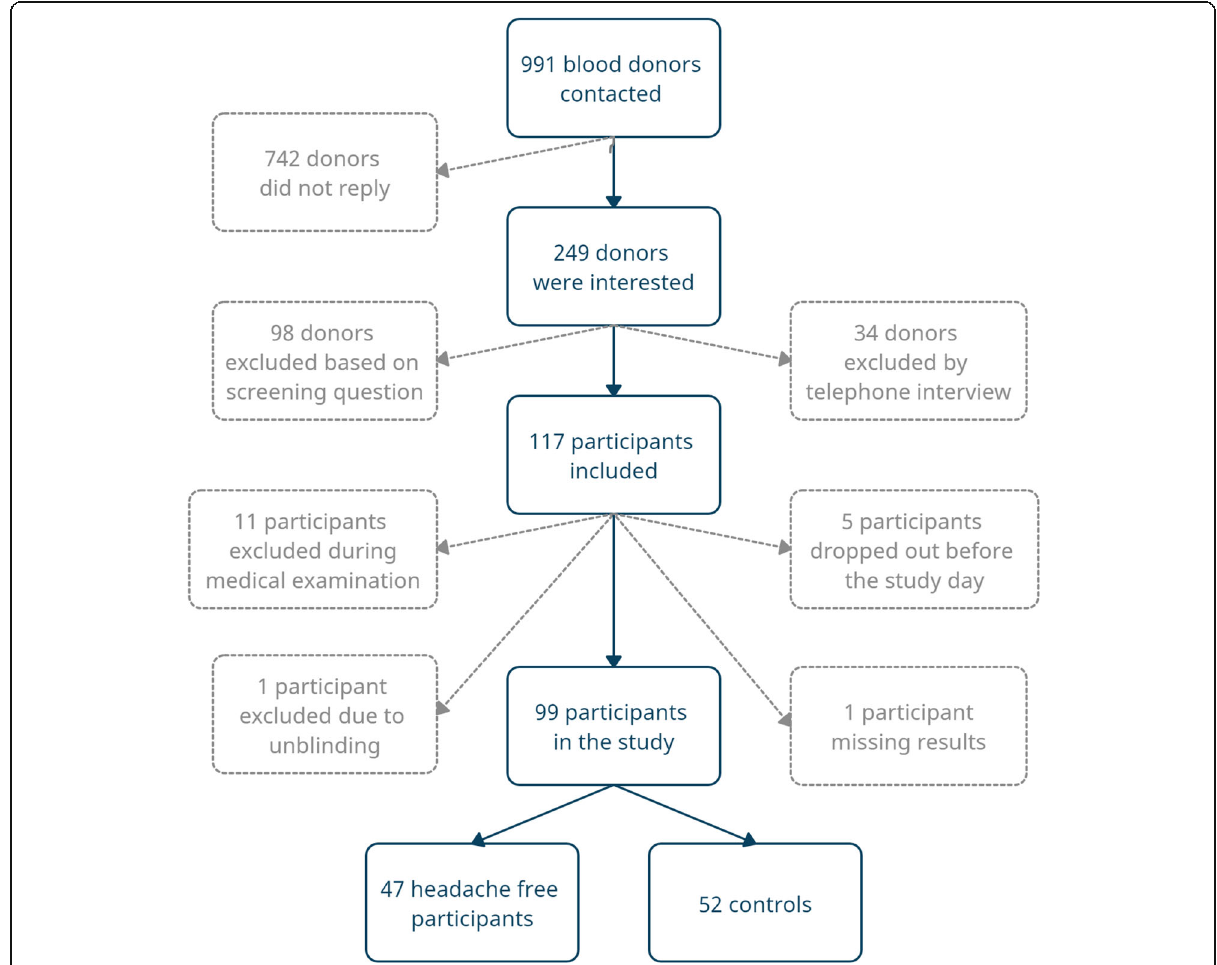
Fig. 1 Inclusion of participants. Flowchart illustrating inclusion and exclusion of participants for the